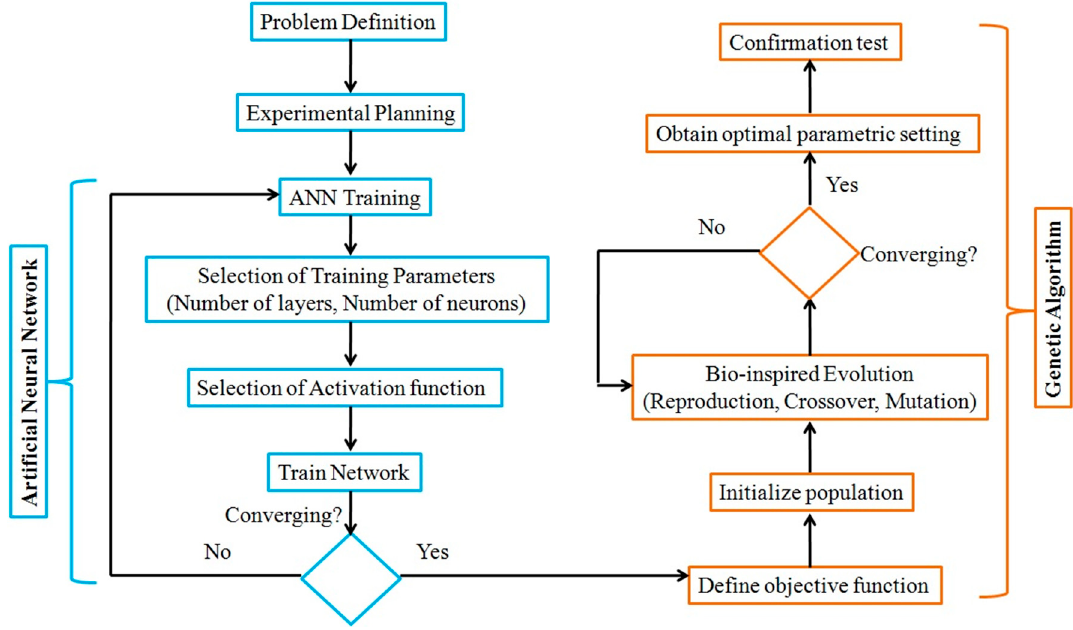
Figure 3. The integrated ANN-genetic algorithm (GA) approach for the modeling and prediction of fractal dimension in WEDM.